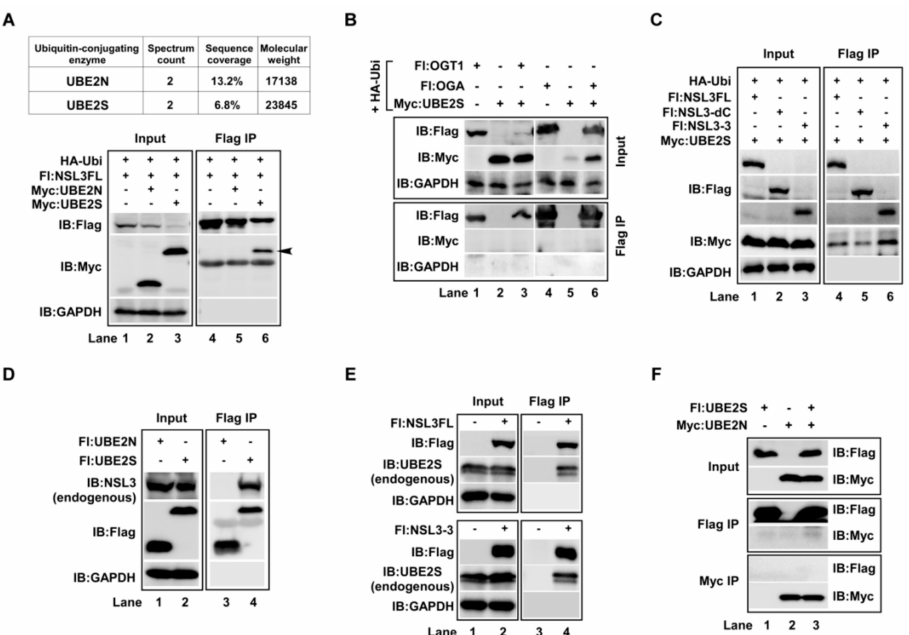
Figure 2. Ubiquitin-conjugating enzyme UBE2S, but not UBE2N, directly bound to NSL3. “ + , − ” in figures caption means with or without. ( A ) NSL3FL bound to UBE2S. UBE2N and UBE2S were identified by mass spectrometry in anti-Flag eluate from stably expressing Flag-NSL3 293FRT cells (upper). 293T cells were co-transfected with Flag-NSL3FL and Myc-UBE2N or Myc-UBE2S, and the interaction between proteins was measured by WB with anti-Flag or anti-Myc antibodies followed by Flag IP (lower). ( B ) No-interaction between UBE2S and OGT1 or OGA. Co-transfection and co-IP were performed as designed. ( C ) UBE2S and NSL3FL were widely combined with each other. Myc-UBE2S was co-transfected with Flag-tagged NSL3FL or deletion mutants of NSL3. Forty-eight hours after transfection, the interaction between UBE2S and NSL3 was visualized by WB. ( D ) Flag-UBE2S bound to endogenous NSL3. 293T cells were transfected with Flag-tagged UBE2N or UBE2S, and Flag-IP was performed after 48 h transfection. Bound endogenous NSL3 was detected using WB with anti-NSL3 specific antibody. ( E ) Flag-NSL3FL (upper) and Flag-NSL3-3 (lower) bound to endogenous UBE2S. ( F ) No-interaction between UBE2S and